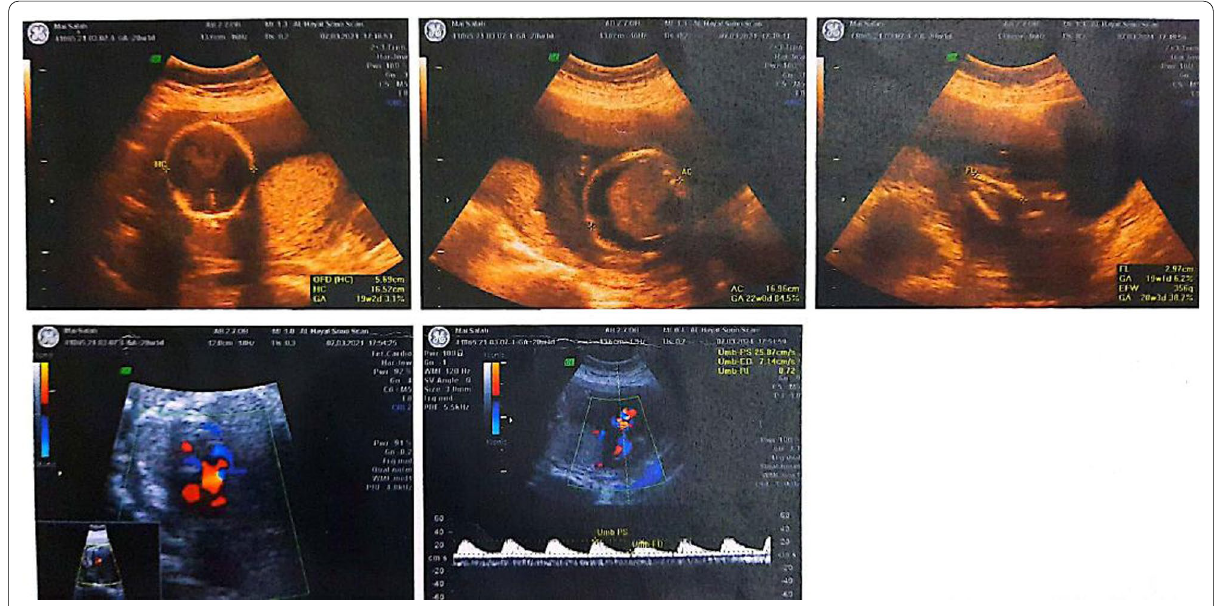
Fig. 1 4D obstetric ultrasonography in the 20th gestational week